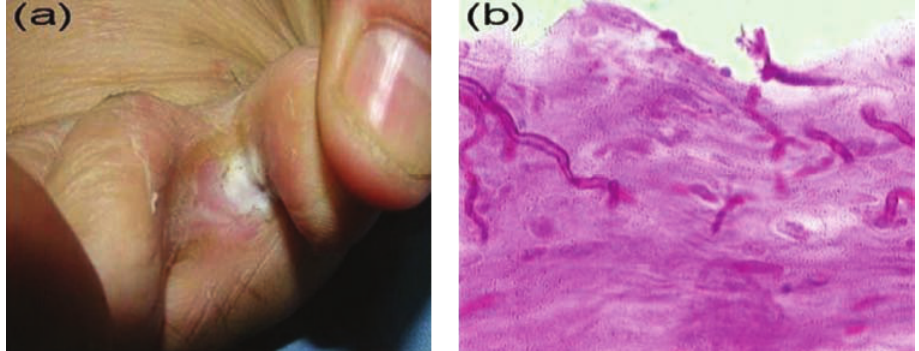
Figure 2: Interdigital fungal intertrigo. (a) Interdigital whitish plaques with macerated, sodden skin. (b) Biopsy from the lesion showing fungal pseudohyphae in the stratum corneum (PAS, × 400).